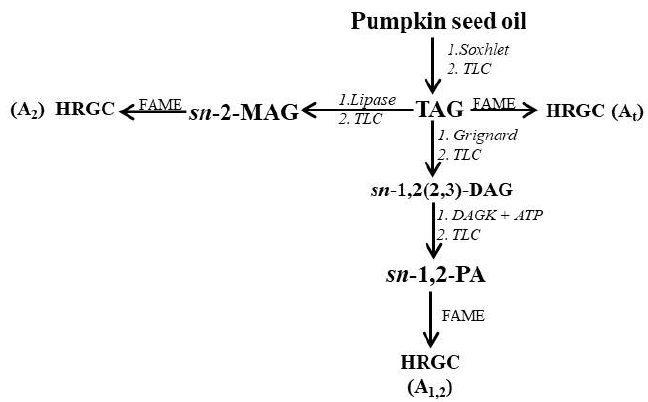
Figure 1. Scheme of the procedure used for stereospecific analysis of TAG from pumpkin ( C. maxima , var. Berrettina) seed oil. HRGC: high-resolution gas chromatography;